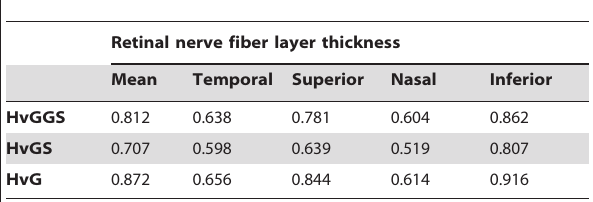
Table 3. Area under the receiver operating characteristic curves (AUCs) of conventional circumpapillary RNFL (cpRNFL) thickness measurements in global and four quadrants from Cirrus HD-OCT software.